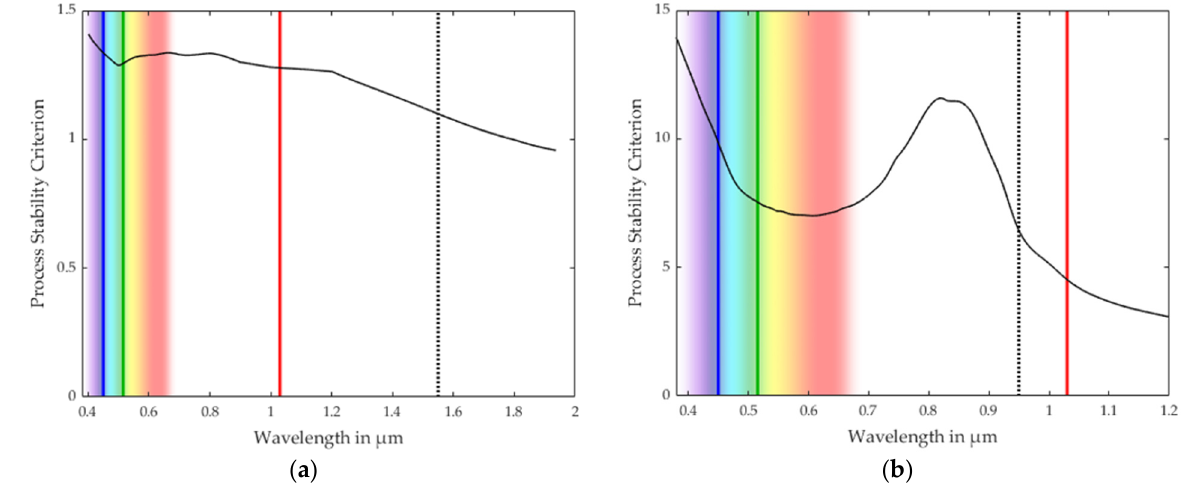
Figure 5. Absorptivity of iron ( a ) and aluminum ( b ) in the solid (solid lines) and liquid state (dashed lines). The vertical blue, green and red lines indicate the wavelengths of commercial blue, green and IR beam sources at 450 nm, 515 nm and 1030 nm, respectively, as a guide to the eye. The vertical black dotted lines indicate the X-points at ∼ 1.55 µ m and ∼ 950 nm . Please note the varying scaling. For the data of solid aluminum, the measurement accuracy is not explicitly given in the source.